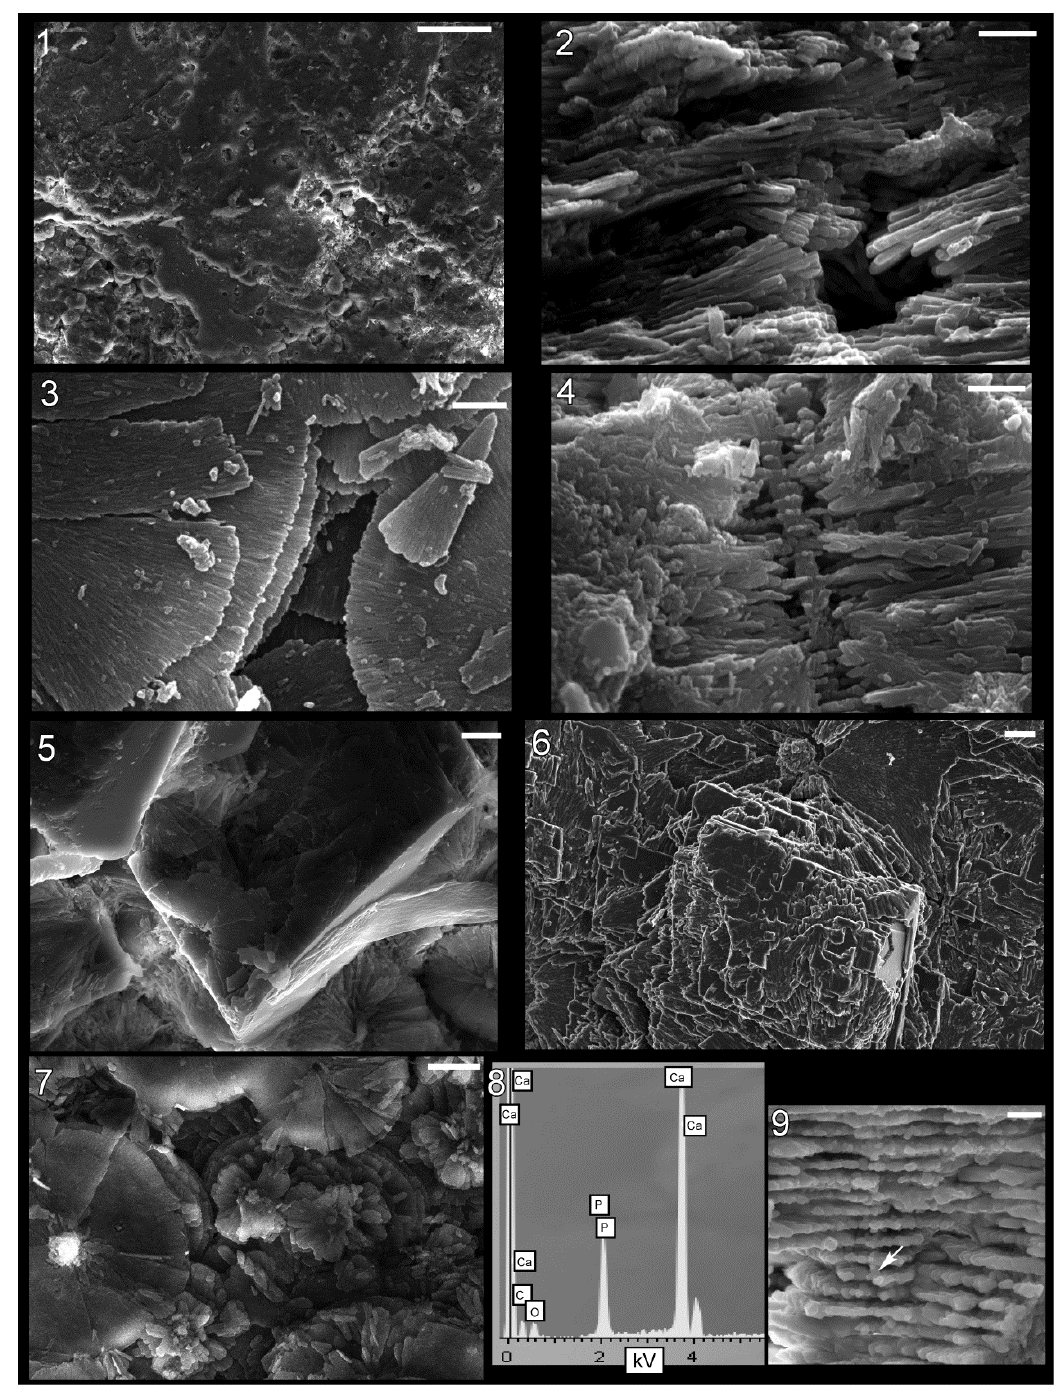
Figure 4. Shell microstructure in specimens of Isorthoceras from the Ordovician Maquoketa Formation. ( 1 ), ( 5 ) and ( 7 ) LACMIP 14439, horizontal sections of internal shell layer near internal surface, view is towards external surface; ( 2 ) and ( 4 ) LACMIP 14438, transverse sections of middle shell layer, top of photographs is external; ( 3 ) LACMIP 14440, horizontal section of inner or middle shell layer, top of discs is internal; and ( 6 ), ( 8 ) and ( 9 ) LACMIP 14437: ( 6 ) horizontal section of inner or middle shell layer, view towards external surface; ( 8 ) EDS analysis of crystal within the disc, revealing composition of calcium phosphate; ( 9 ) vertical section through shell showing location of EDS analysis depicted in ( 8 ). Scale bars: 100 µm for ( 1 ); 2 µm for ( 2 )–( 4 ); 10 µm for ( 5 ); 1 µm for ( 6 ) and ( 9 ); and 5 µm for ( 7